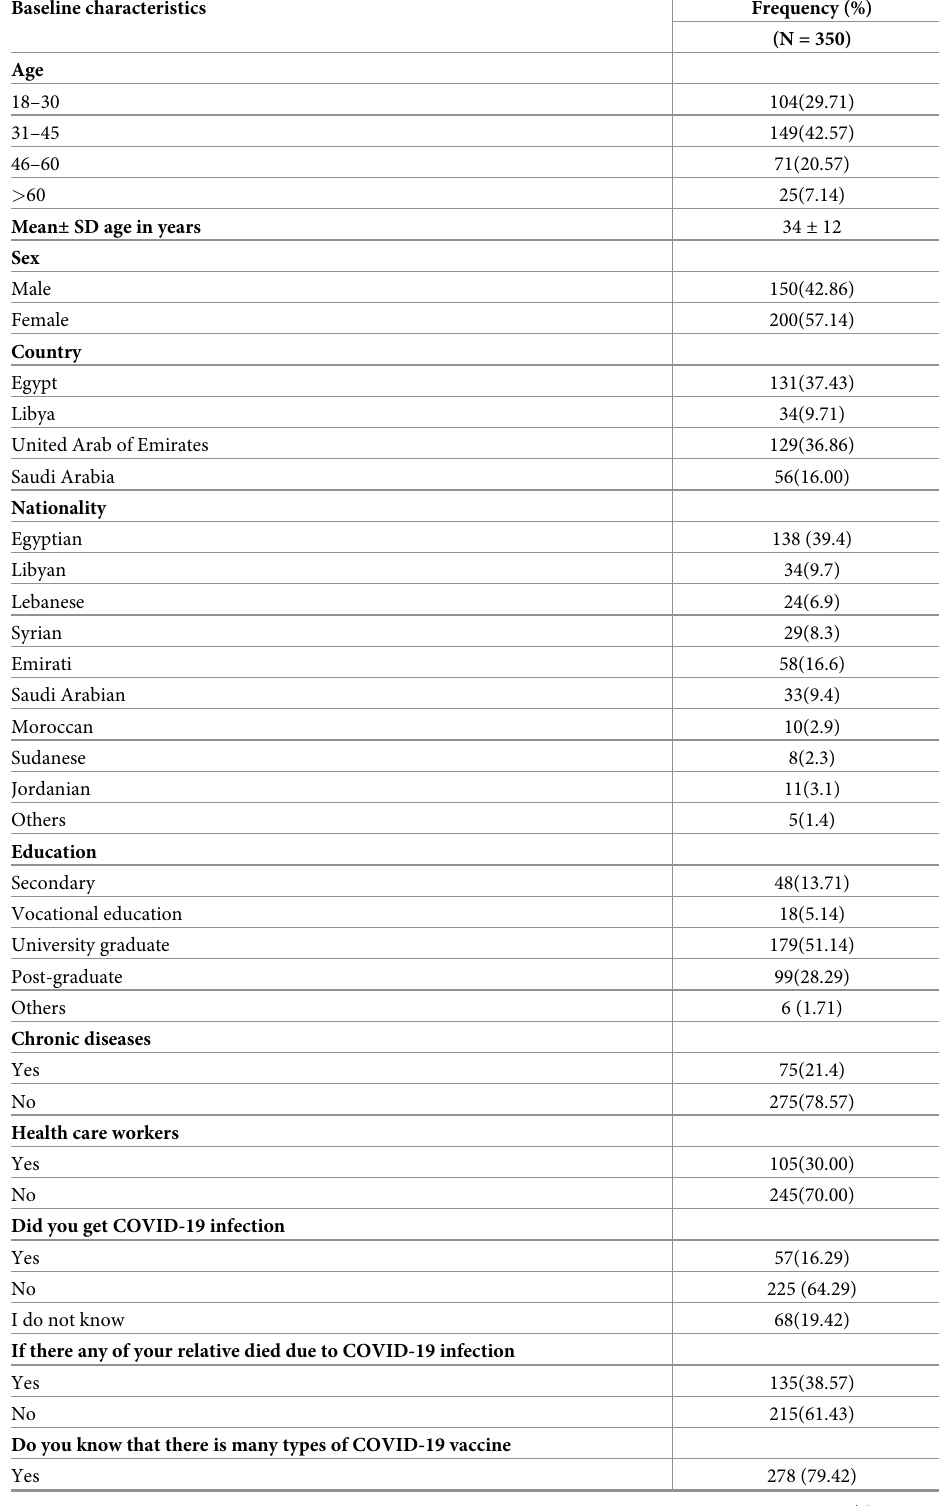
Table 1. Baseline characteristics of study